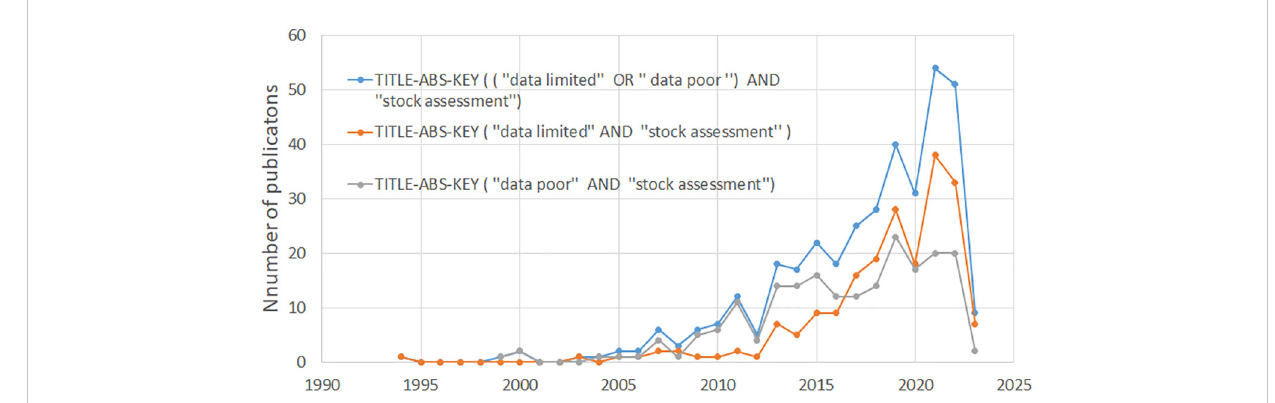
FIGURE 1 Number of publications by year relevant to this research topic. Source: www.scopus.com.